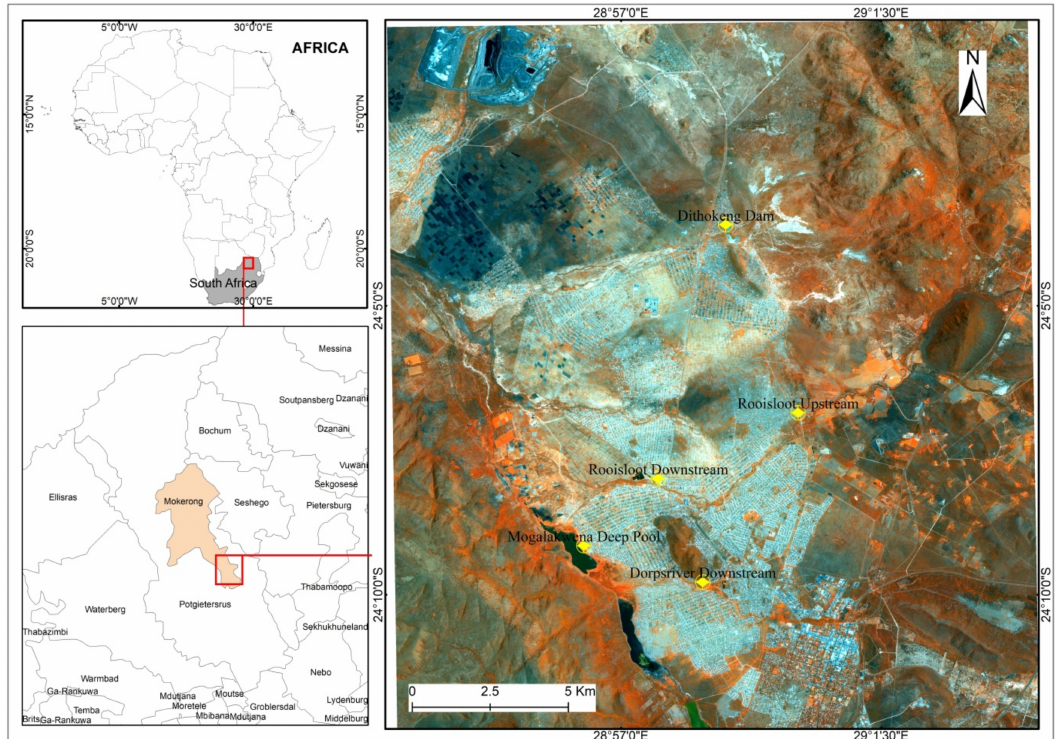
Figure 1. Study area map with sampling location. The sampling sites are indicated through upstream to downstream.